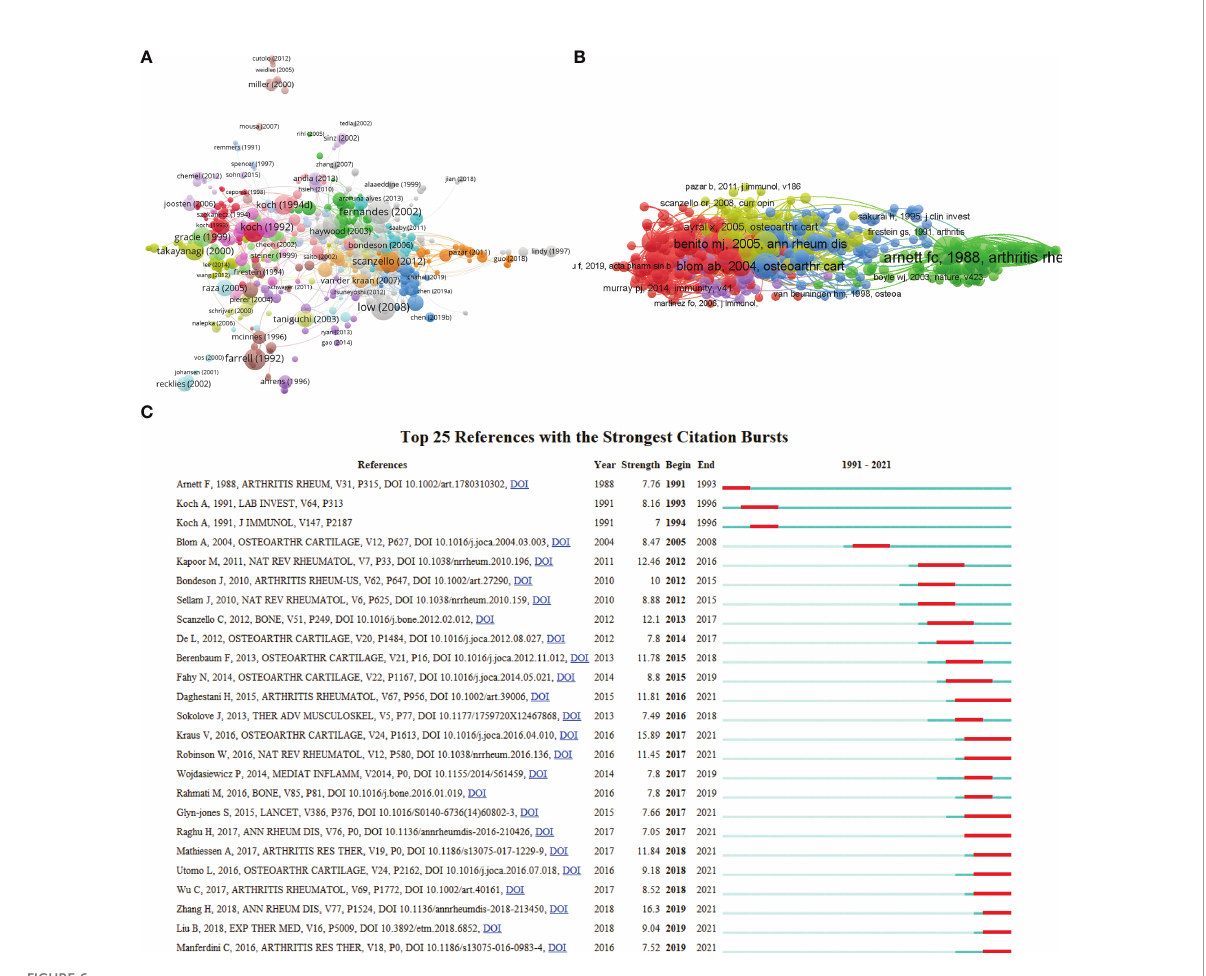
According to Figure 8B, the VOSviewer colored all keywords papers. Speci fi cally, the color blue indicates that the